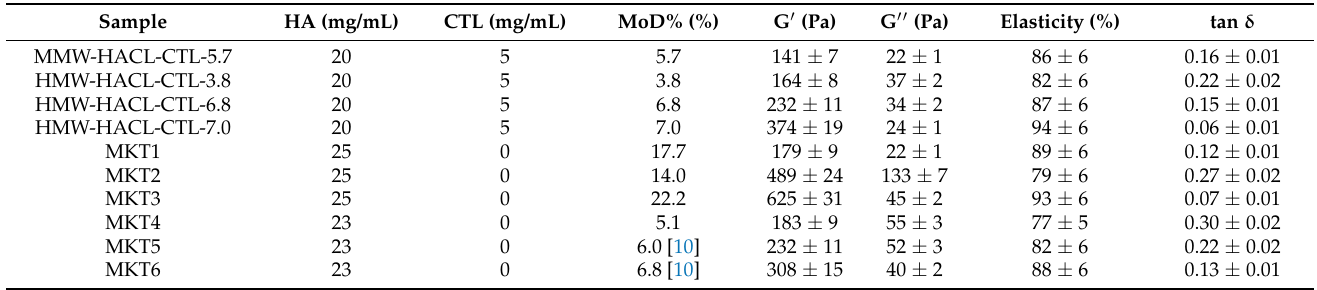
Table 2. Viscoelastic properties at 1 Hz of selected samples produced in this work and of some com- mercial samples (MKT 1–6). * Sample MMW-HACL-CTL-5.7 was prepared with medium molecular weight hyaluronic acid, while HMW-HACL-CTL-3.8, HMW-HACL-CTL-6.8 and HMW-HACL-CTL- 7.0 with high molecular weight hyaluronic